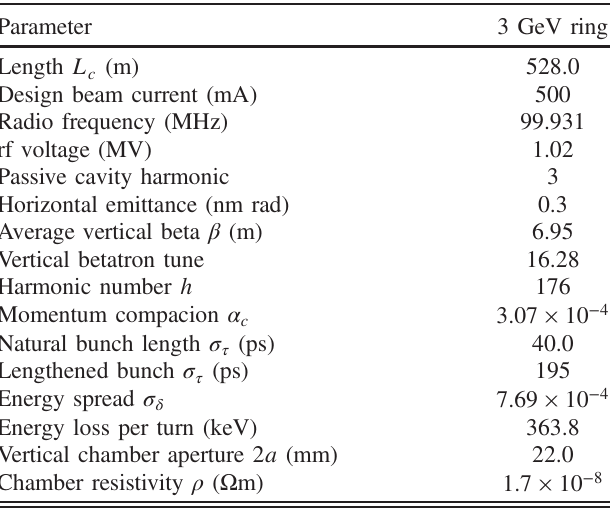
TABLE I. The main parameters of the MAX IV 3 GeV storage ring in the MAX IV facility as used in this paper. The values correspond to the bare machine with no insertion